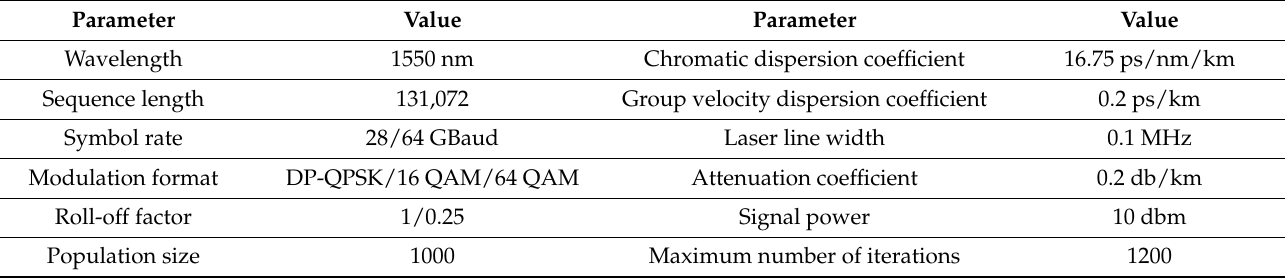
Table 2. System simulation